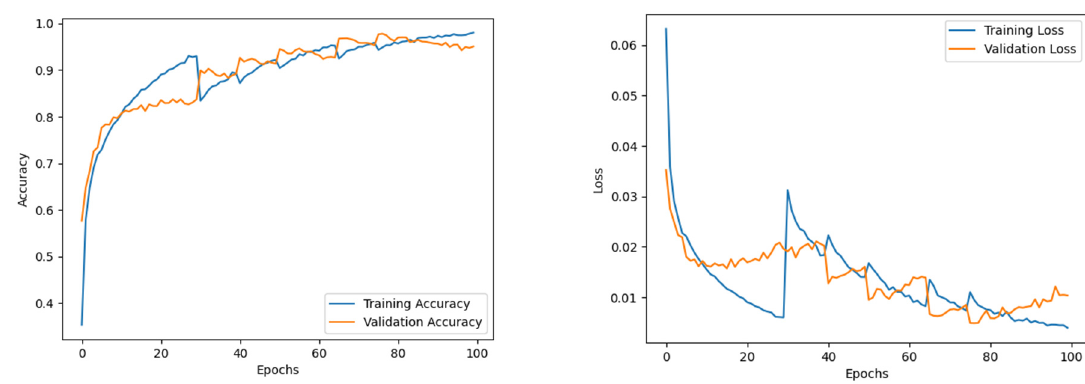
Figure 7. Accuracy and loss of combined model.